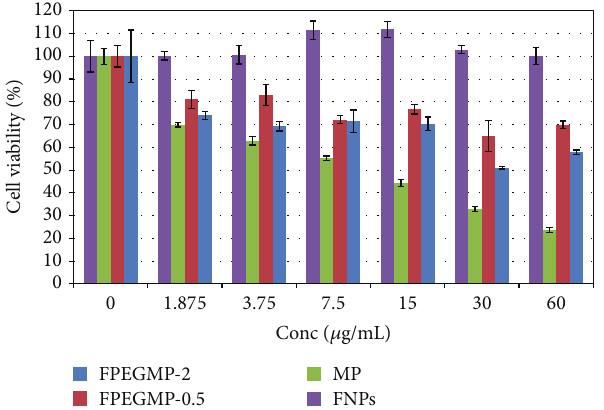
Figure 8: Showing in vitro cytotoxicity studies of WEHI-3B cells after 48 hours of exposure to free MP, iron oxide nanoparticles (FNPs), FPEGMP-0.5, and FPEGMP-2 nanocomposites. The two nanocomposites (FPEGMP-0.5 and FPEGMP-2) and pure MP showed continuous cell viability, decreased with each increase in dose. Their IC 50 values were found to be 10 ± 0.5 𝜇 g/mL, 30 ± 3.0 𝜇 g/mL, and 6.0 ± 2.0 𝜇 g/mL for MP, FPEGMP-2, and FPEGMP- 0.5, respectively, as obtained from the graph and calculated via regression